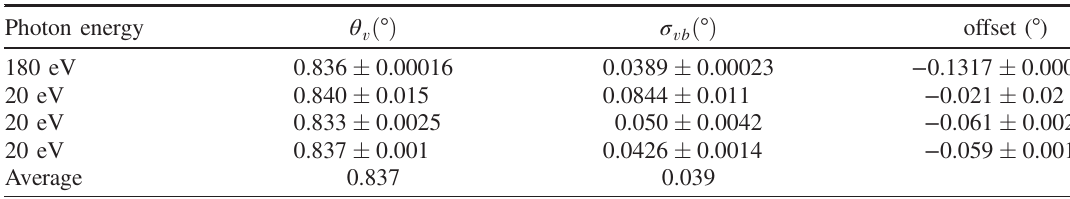
TABLE II. Summary of fits to no-sample detector scans in θ 2 . An overall offset from θ 2 ¼ 0 , shown in the third column, was also a free parameter in the